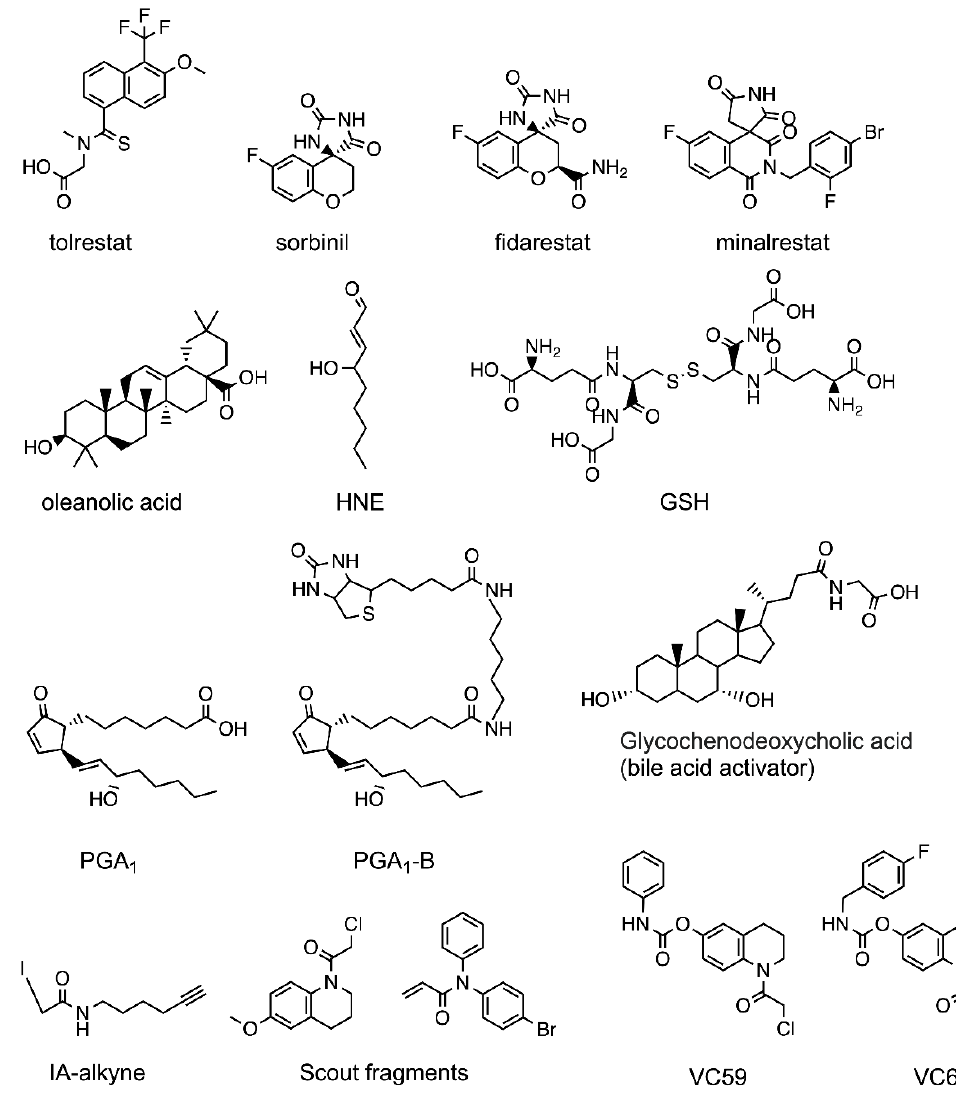
Figure 1. Molecular structures of some of the compounds cited in the manuscript. Molecular formulas were made with ChemDraw 19.0.0.26.